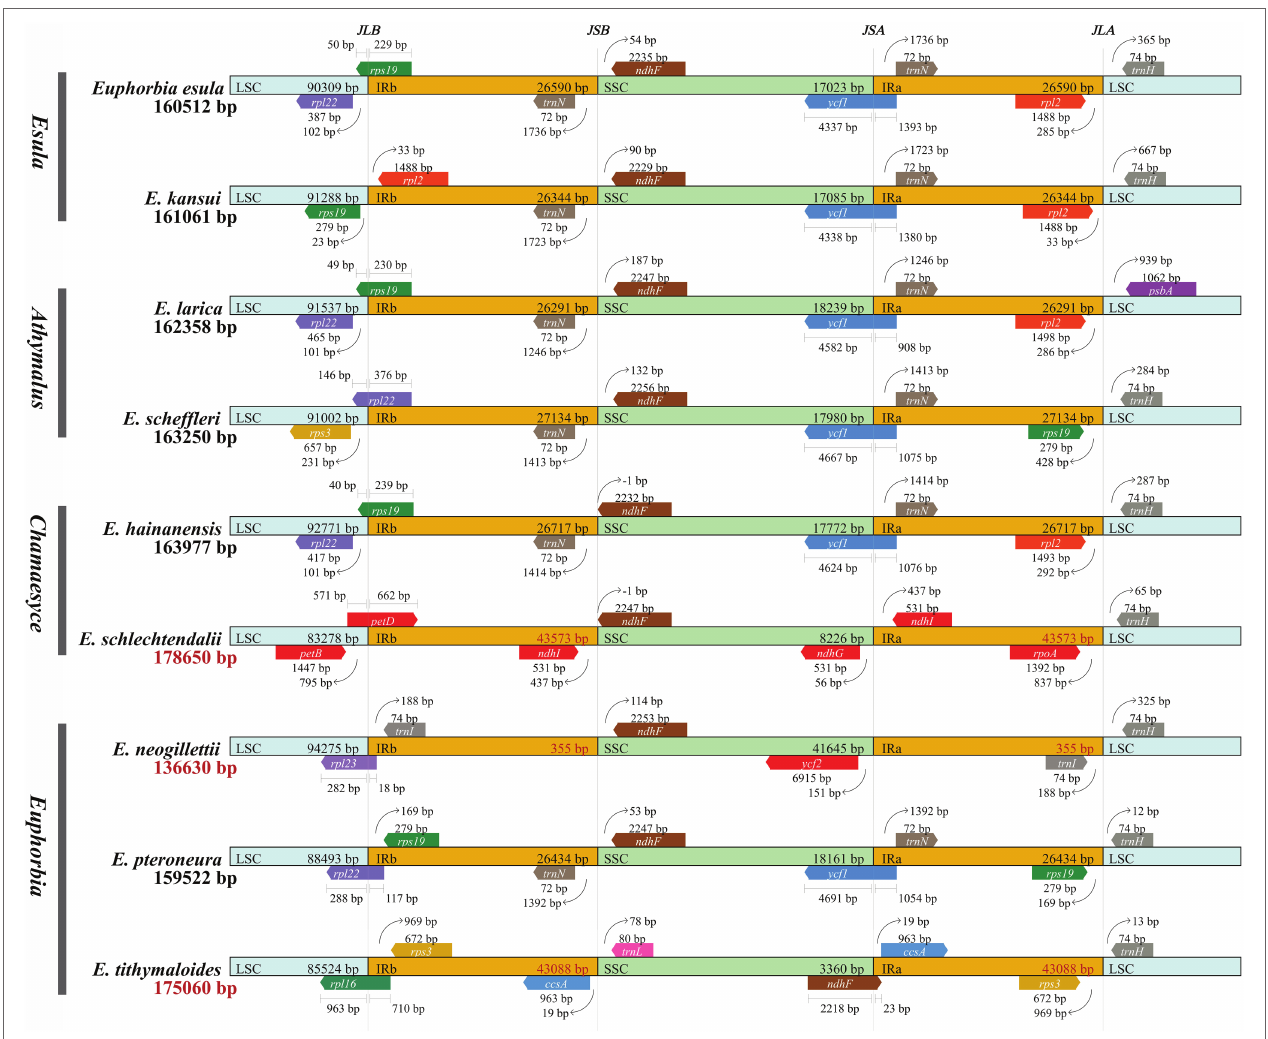
FIGURE 3 | Comparison of IR-single copy (SC) boundary positions across plastomes of nine Euphorbia species in four subgenera. Colored boxes indicate gene structures and arrows indicate the direction of genes (pointing to the left: negative strand; to the right: positive strand). Gaps between the genes and the boundaries are indicated by the base lengths (bp). Abbreviations denote junction sites of the plastid genome, JLB (LSC/IRB), JSB (IRB/SSC), JSA (SSC/IRA), and JLA (IRA/LSC). LSC, SSC, IRA, and IRB indicate large single copy (LSC), small single copy (SSC), IR region A, and IR region B, respectively. The plastome length of species without large-scale IR expansion/contraction (Group A) is in black, whereas the plastome length of species with large-scale IR expansion/contraction (Group B) is in